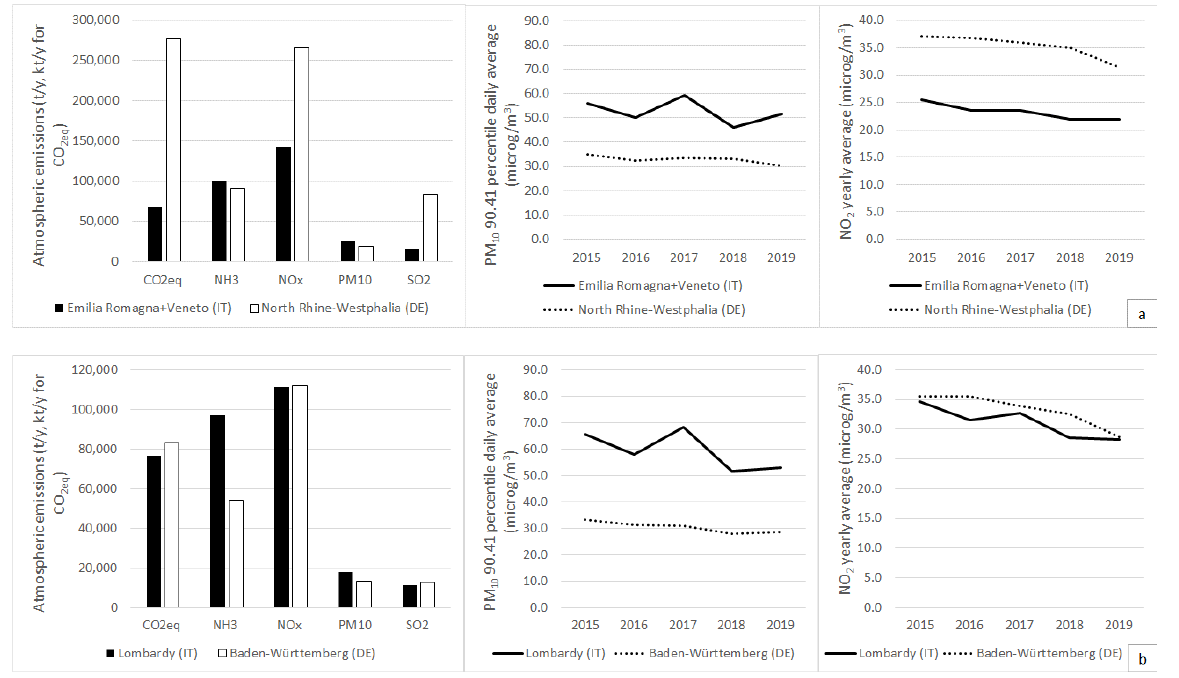
Figure 2. ( a ) Emission inventory for North-Eastern Italy (Emilia Romagna + Veneto regions) and North Rhine-Westphalia in Germany; ( b ) emission inventory for Lombardy in Italy and Baden- Württemberg in Germany. Yearly NO 2 concentrations and PM 10 90.41 percentile daily average are reported for the period 2015–2019.